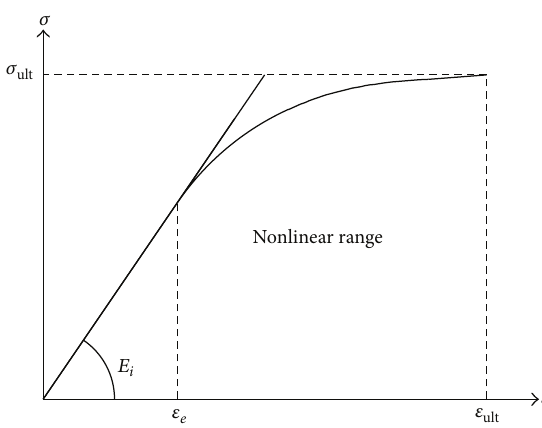
Figure 9: Nonlinear stress-strain relationship. 𝐸 𝑖 = initial or nominal modulus, 𝜀 𝑒 = elastic limit strain, 𝜀 𝜎 = ultimate ult